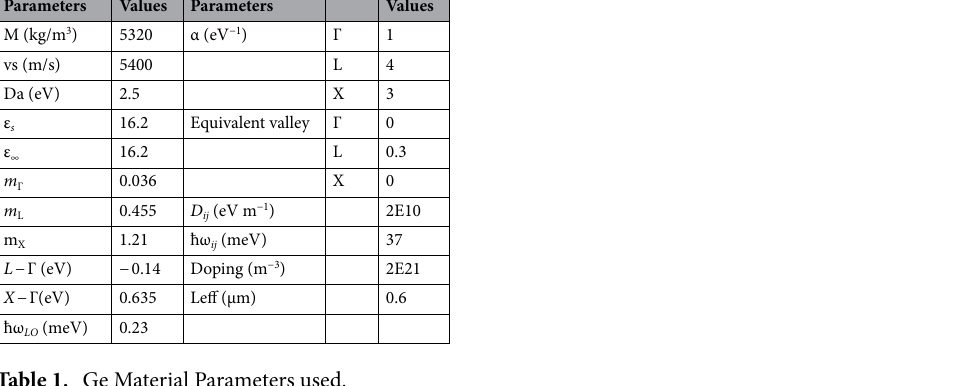
Table 1. Ge Material Parameters